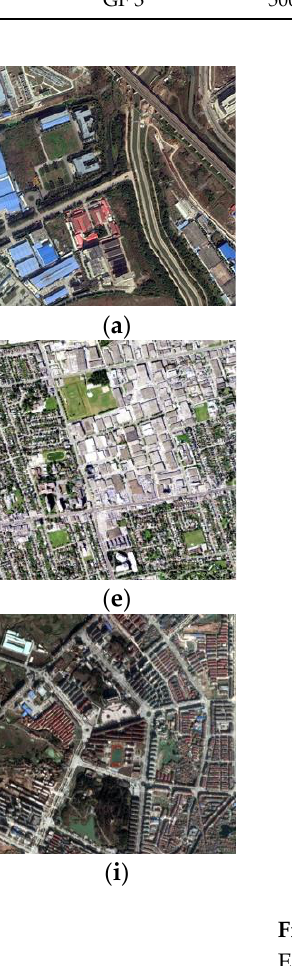
Figure 8. The registration performance of the MSPCO algorithm is evaluated quantita- tively by two metrics: NCM and RMSE.